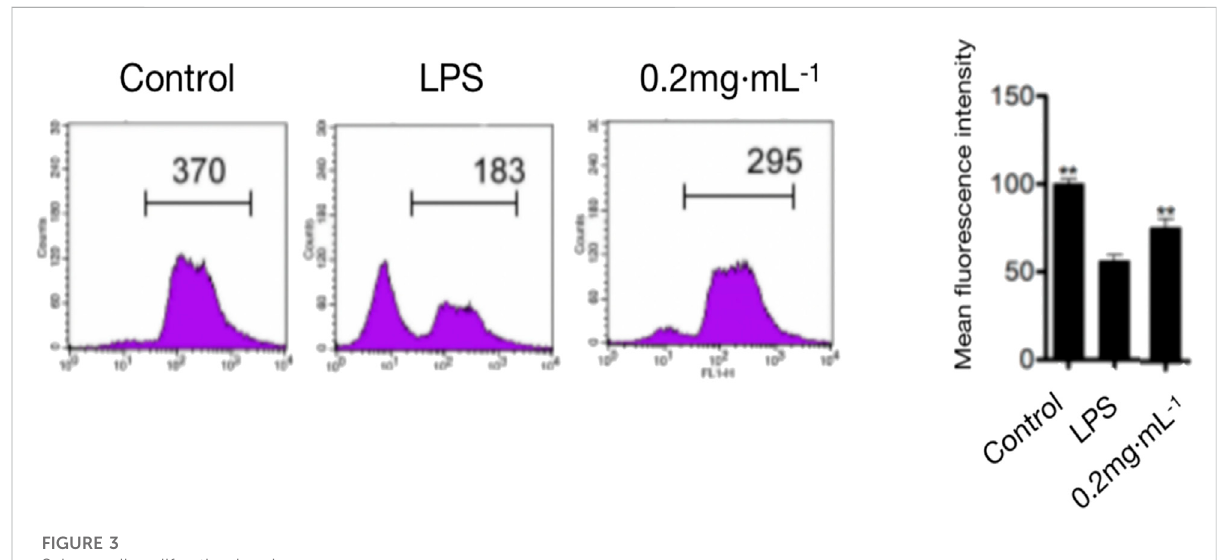
FIGURE 3 Spleen cell proliferation in